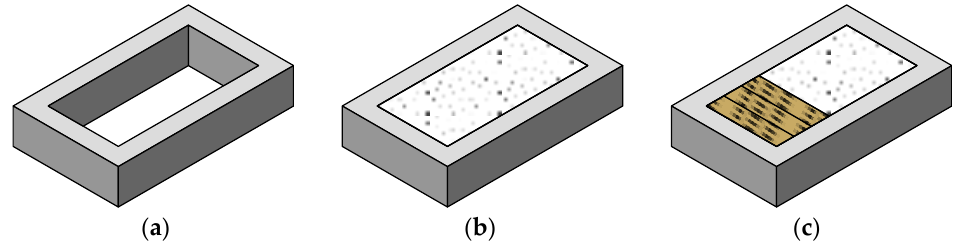
Figure 9. ( a ) Foundation frame, ( b ) foundation frame filled with gravel/stones, ( c ) installed wooden beams on the floor. beams on the